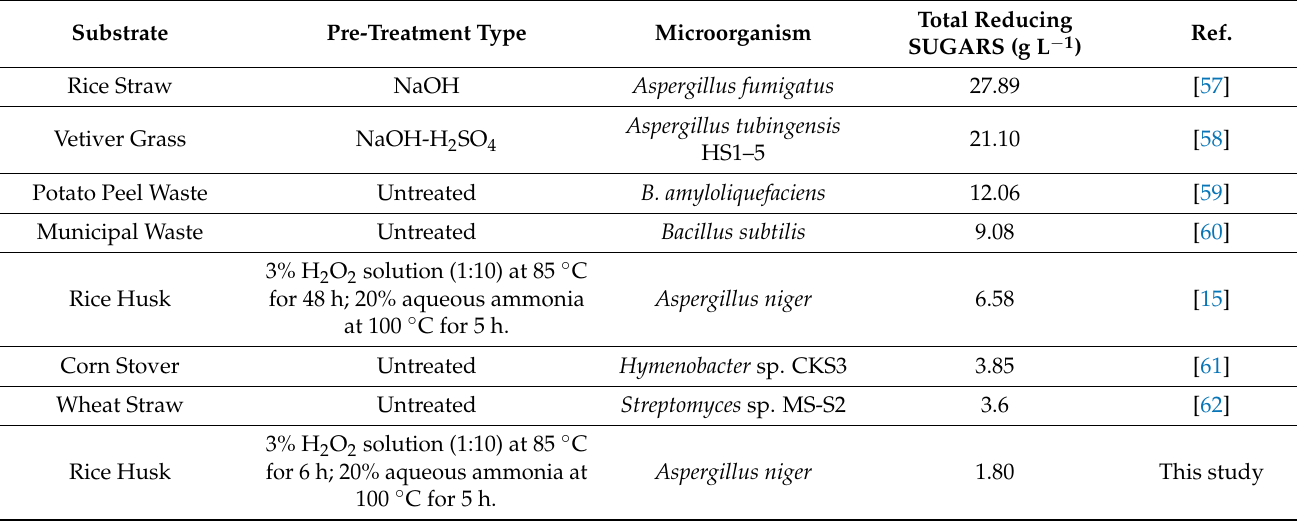
Table 5. Comparison of total reducing sugar concentrations reported for various substrates, pre- treatments, and microorganisms (including the present